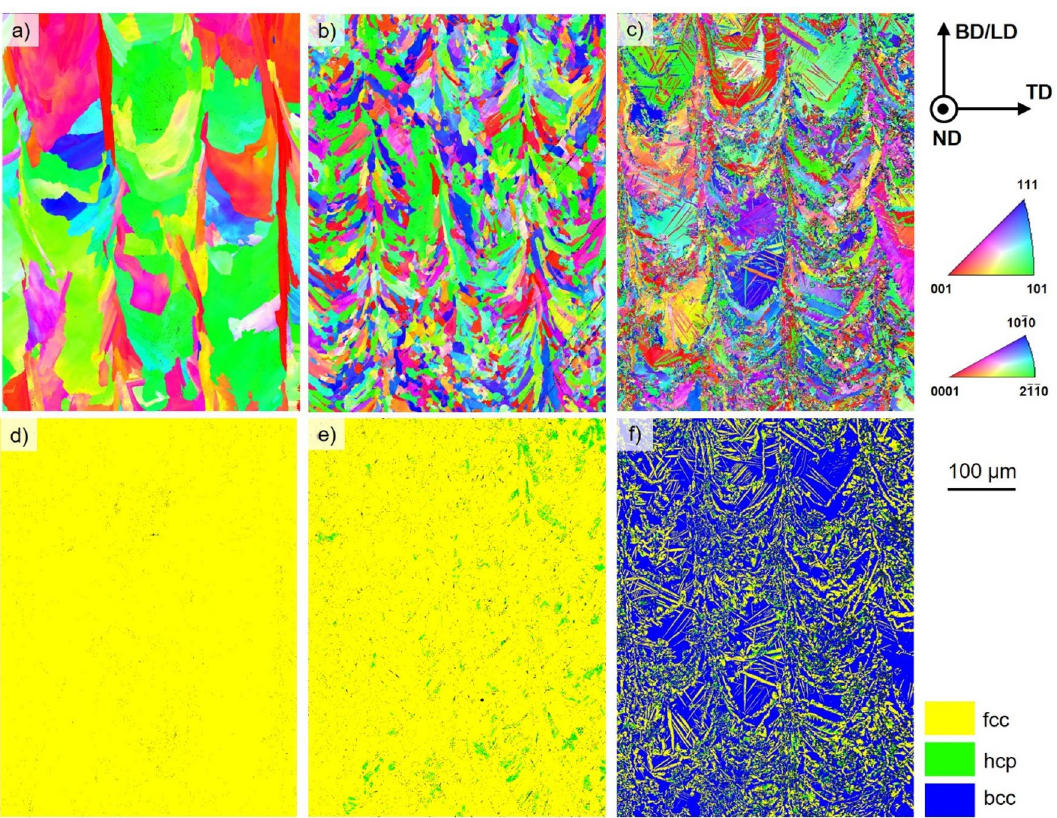
Figure 1. EBSD orientation maps plotted with respect to build direction || loading direction (BD || LD) and corresponding phase maps of PBF-LB/M-16-6-9 ( a , d ), PBF-LB/M-16-6-6 ( b , e ), PBF-LB/M-16-6-3 ( c , f ). In dependence of the alloy composition face-centered cubic (fcc), body-center cubic (bcc) as well as hexagonal closed-packed (hcp) phases are seen. The average grain sizes of the 16-6-9 and 16-6-6 alloys are 73.1 µm ± 22.6 µm and 15.8 µm ± 5.1 µm, respectively. The average grain size for the bcc phase is about 21.8 ± 3.4 µm in the 16-6-3 composition, whereas the fcc and hcp phases being present have a